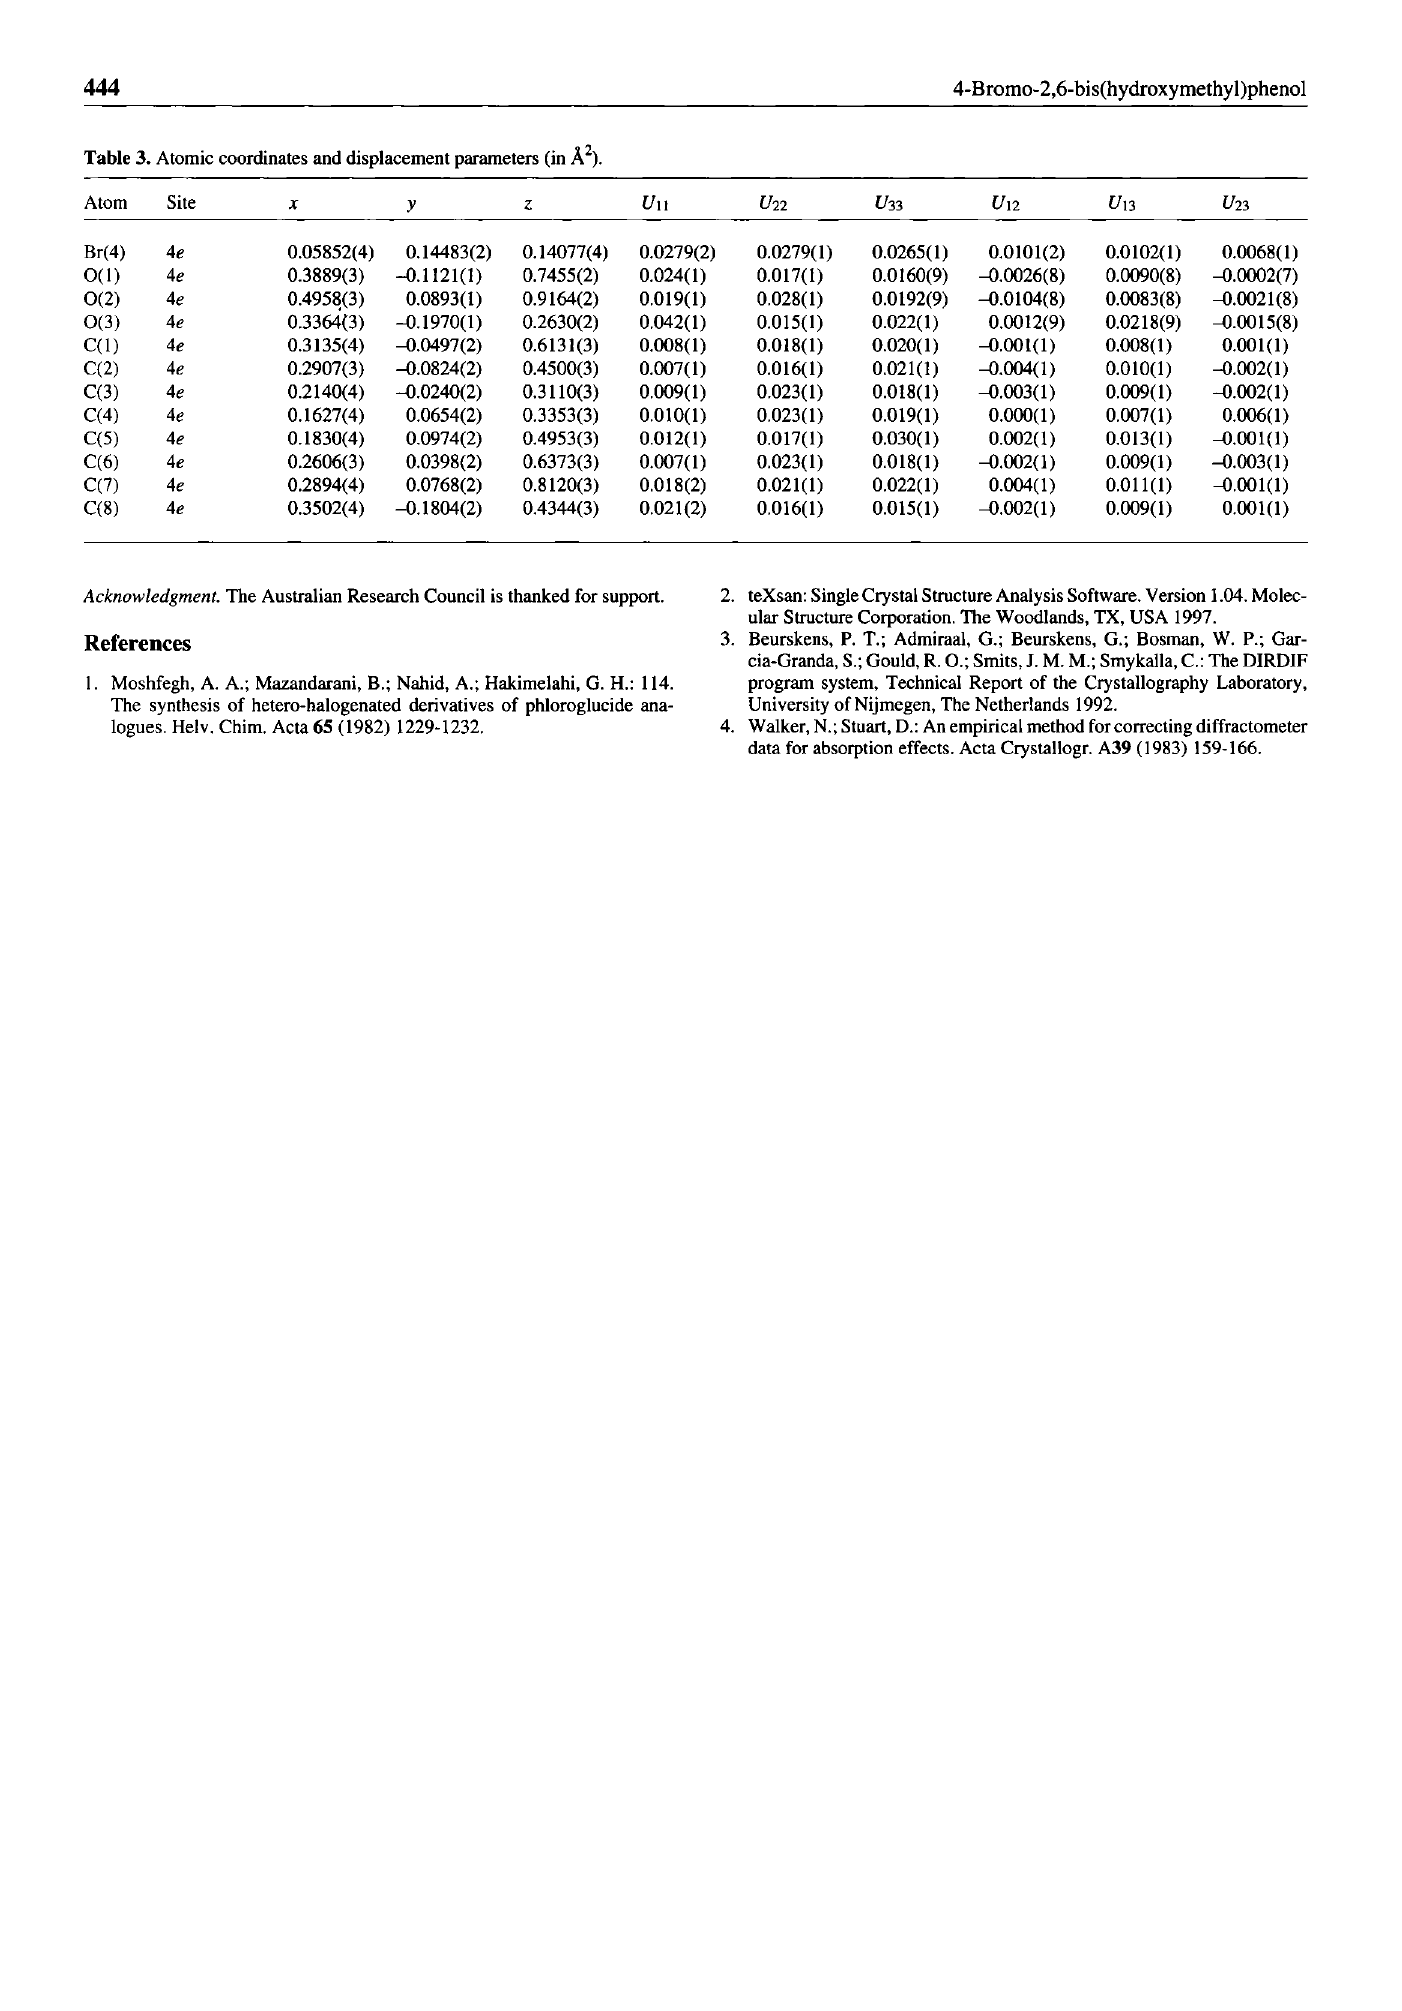
Table 3. Atomic coordinates and displacement parameters (in Ä 2